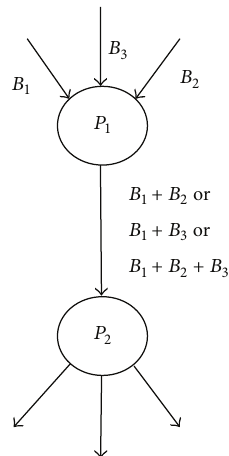
Figure 2: If node 𝑃 1 performs coding operation, 𝑃 1 can send any linear combination of 𝐵 1 , 𝐵 2 , and 𝐵 3 to peer 𝑃 2